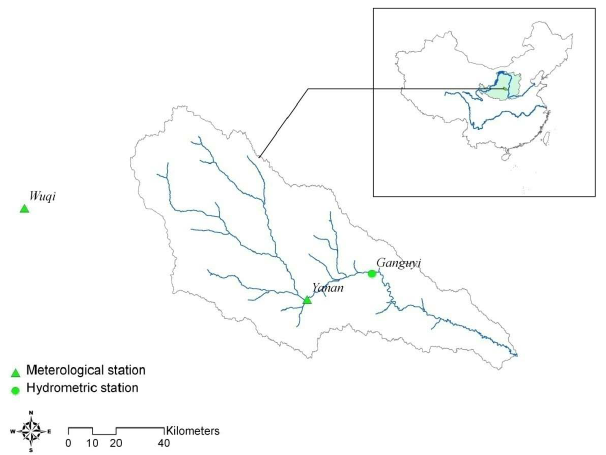
Fig. 2. Study area and the locations of hydrometric station and meteorological station